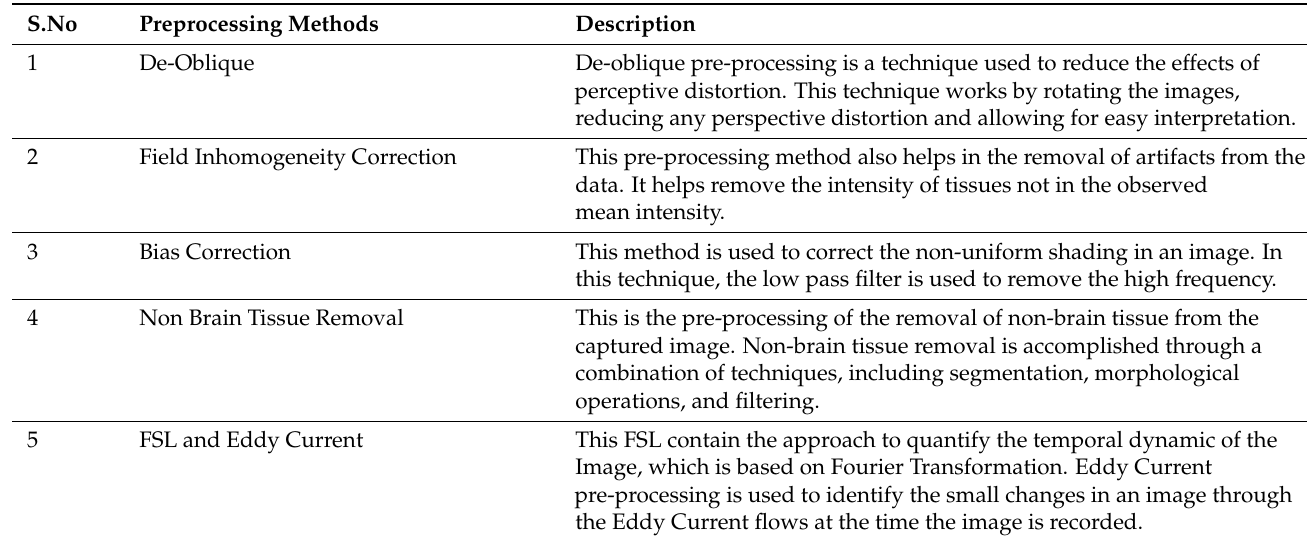
Figure 2. Volume Based Pre-processing Methods for different Biomarkers. Table 3. General Pre-processing Methods used in Structural Biomarkers.